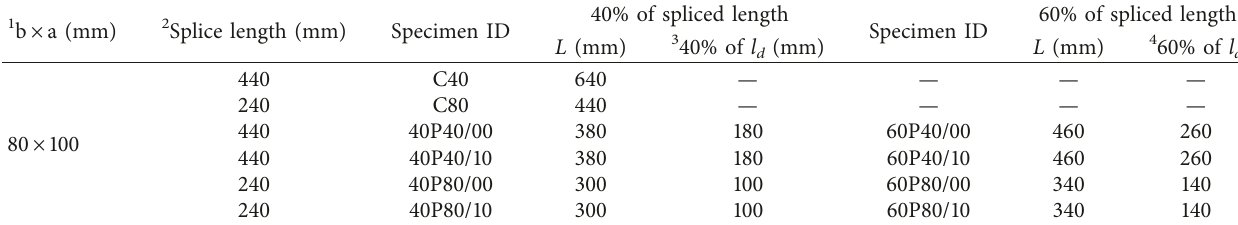
Table 3: Details of test specimens.